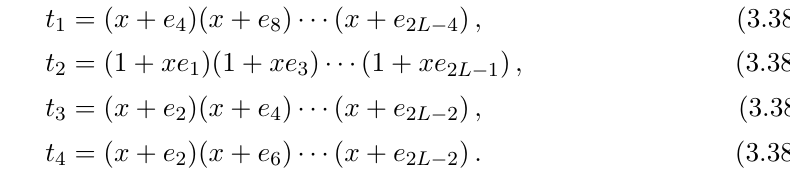
, shown in figure 9, which 1